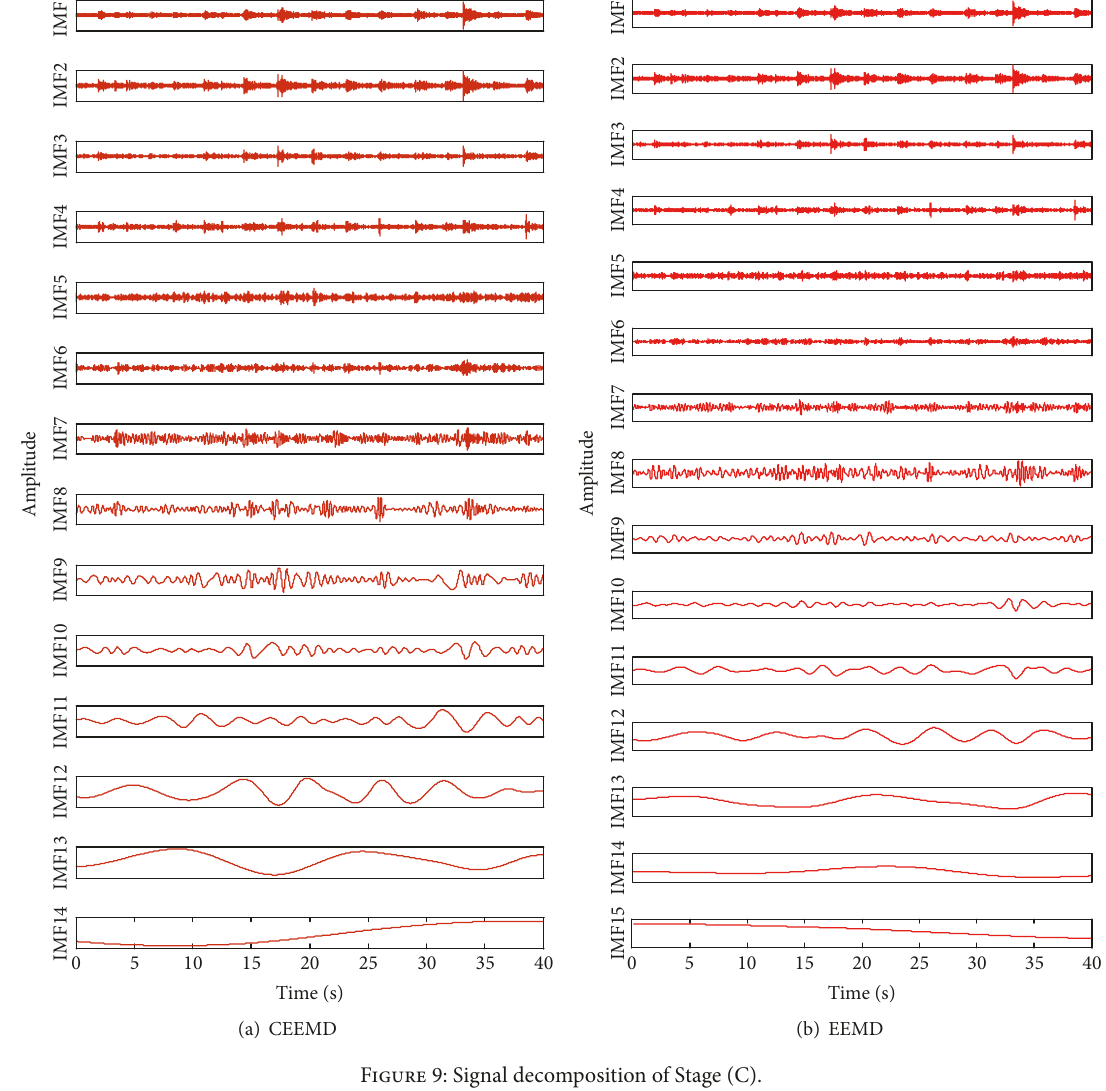
Figure 9: Signal decomposition of Stage (C).